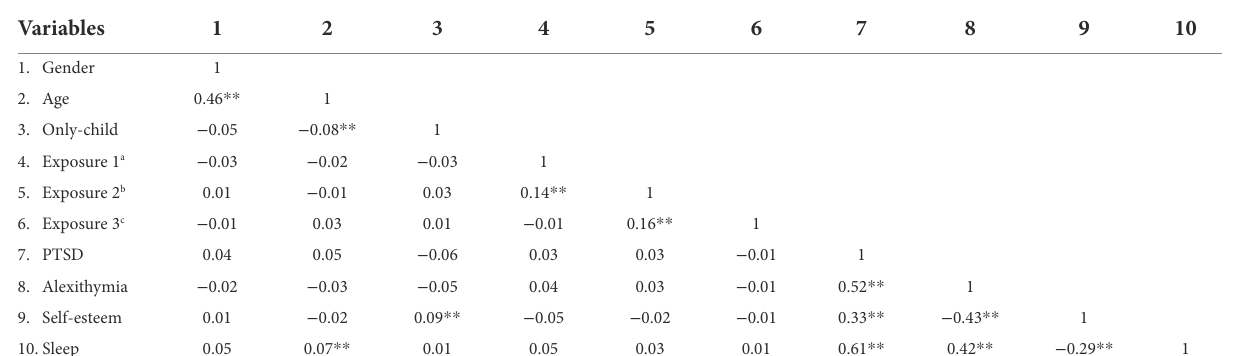
TABLE 2 Correlation coefficients between the main variables ( N =